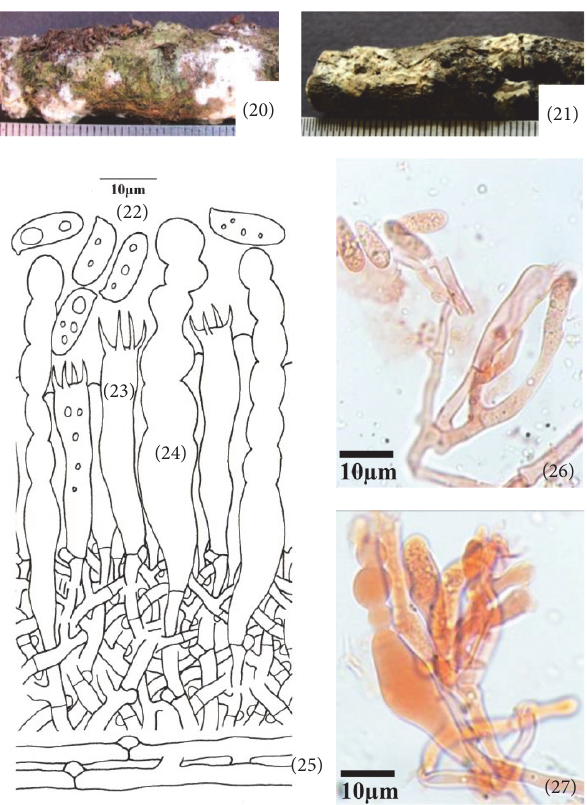
Figure 4: Hyphoderma litschaueri (20)–(27). (20) Fresh basidiocarp, (21) dried basidiocarp, (22) basidiospores, (23) basidium, (24) cystidium, (25) generative hyphae, (26) photomicrographs showing basidiospores and generative hyphae, and (27) photomicrographs showing cystidium and generative